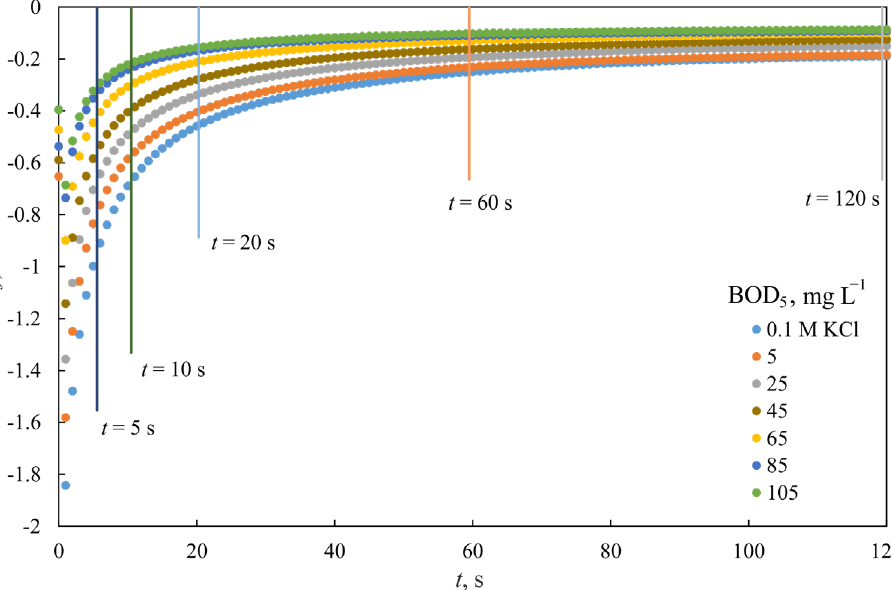
Fig. 8. The biosensor signal (current density, j ) during measurement of CA in solution of OECD wastewater at different BOD 5 values; 2 mL min −1